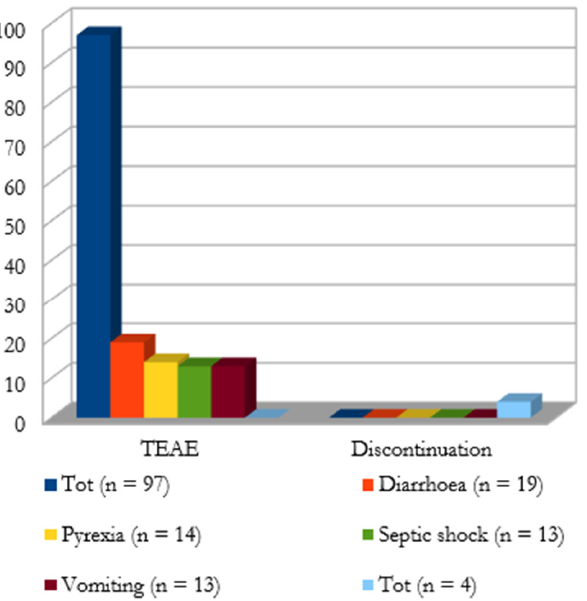
Figure 3. Treatment-emergent adverse events (TEAE) and discontinuation cases; clinical (external ring) and microbiological (internal ring) outcome.